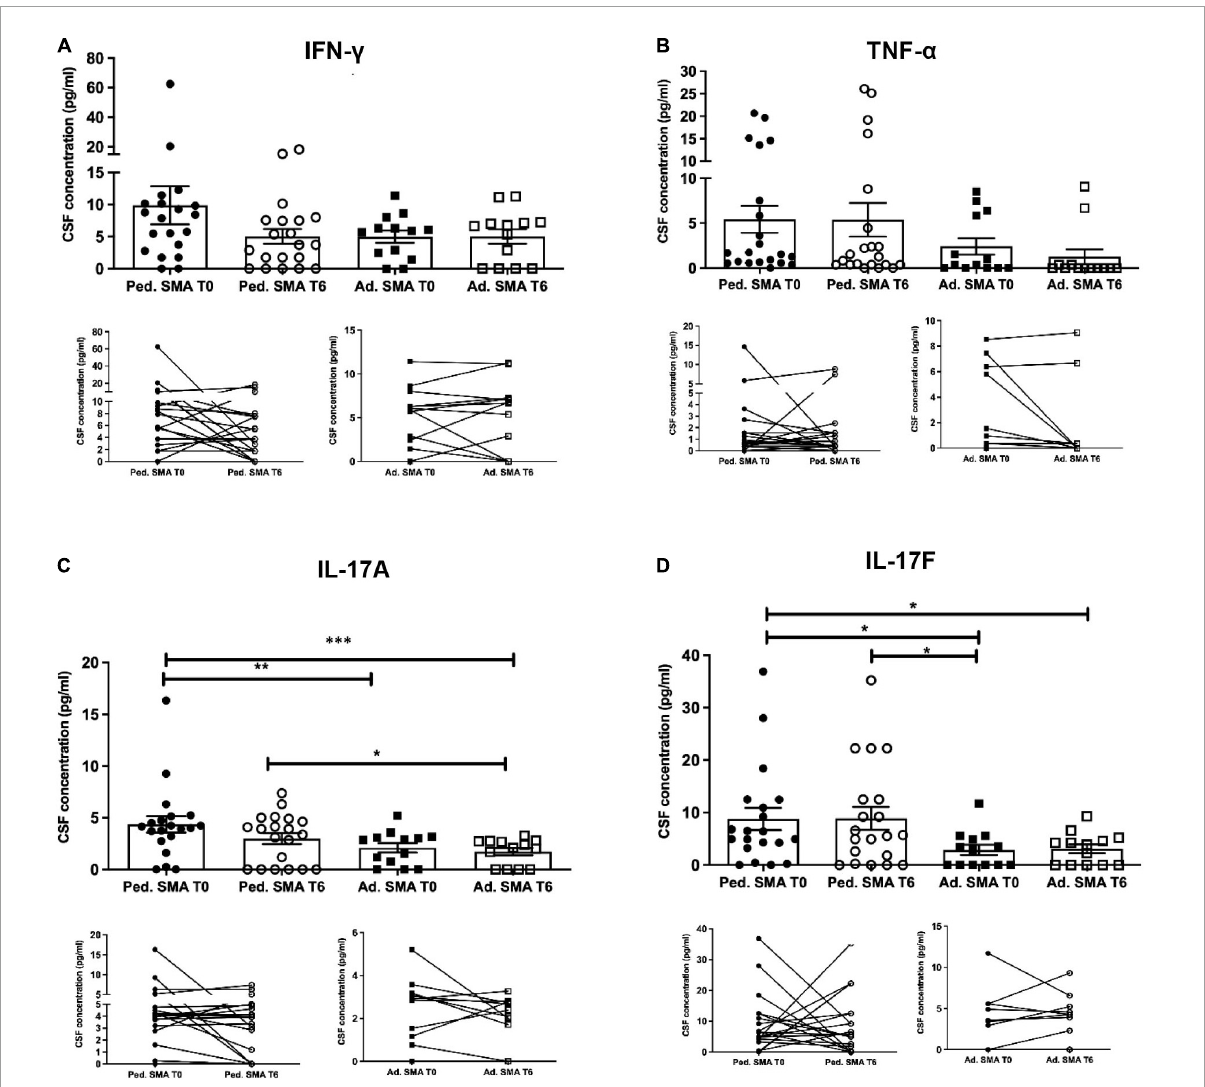
FIGURE5 Levels of cytokines in cerebrospinal fluid (CSF) of pediatric and adult spinal muscular atrophy (SMA) patients. The concentration (pg/ml) of levels of (A) IFN- γ , (B) TNF- α , (C) IL-17A, and (D) IL-17F were measured in the serum of pediatric (Ped.; circle, N = 21) and adult (Ad.; square, N = 13) SMA patients at baseline (T0 black) and after 6 months of nusinersen treatment (T6 white), and in healthy controls (Ad. CTR; gray triangle) by multiplex immuno assay. Data in the graphs are reported as mean ± SEM for each sample group. The before-after graphs contains the mean cytokine concentration obtained for each patient in the duplicate multiplex immunoassays reactions before and after 6 months of nusinersen treatment (T0 and T6). * p < 0.05, ** p < 0.001, p < 0.0001*** by Mann–Whitney